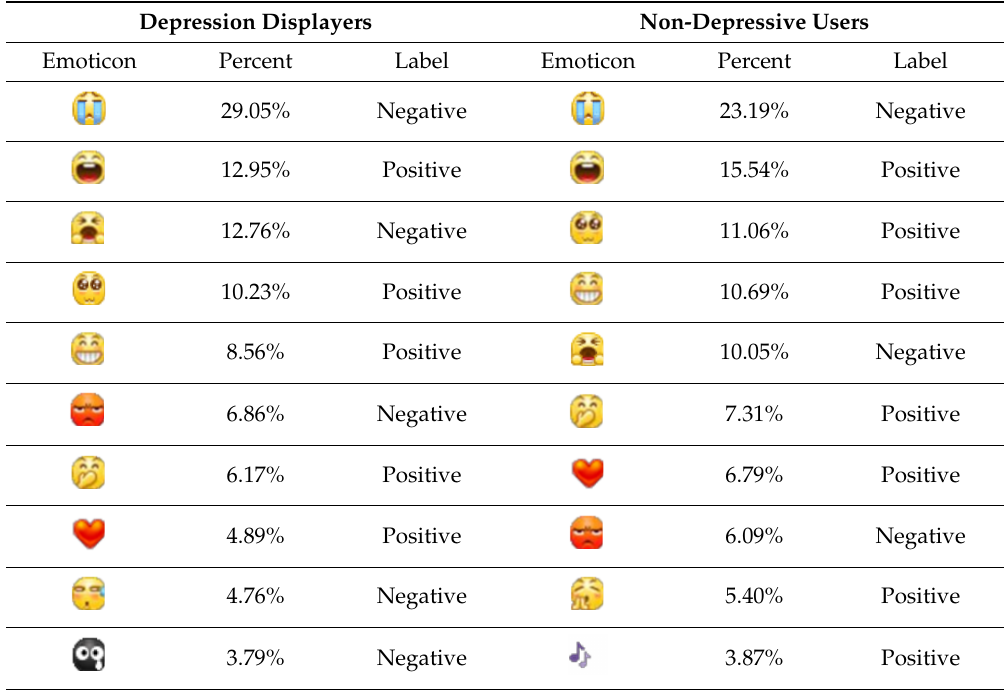
Table 3. Emoticons used by the two